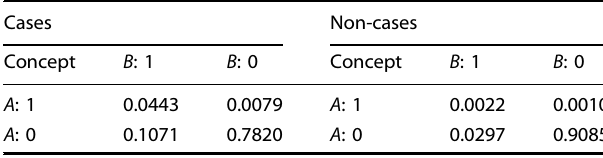
Table 7. Contingency tables for the structured-unstructured pair “ Opioid abuse, unspeci fi ed use ” ( A ) and “ junk (heroin) ” ( B